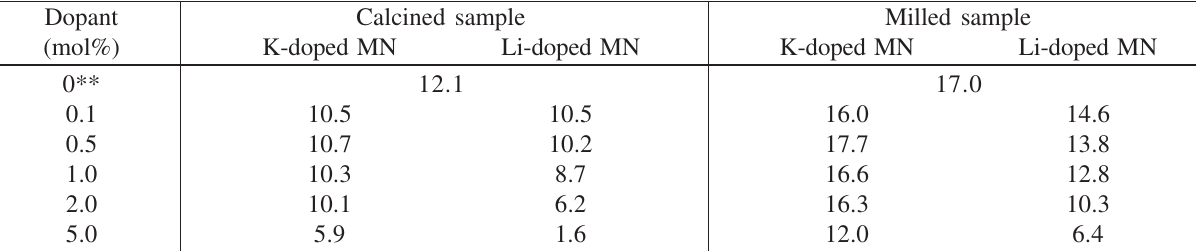
Table 4. Surface area* for columbite precursor samples.